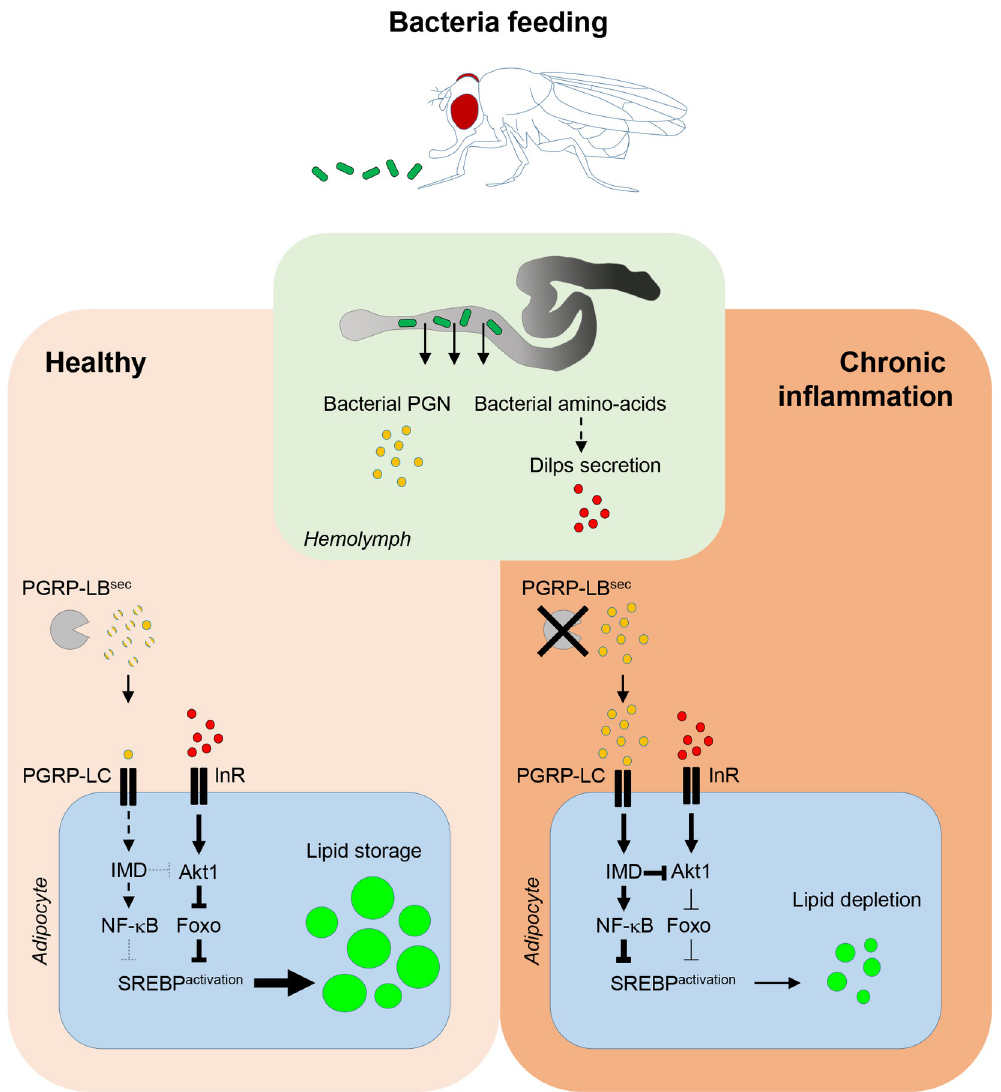
triggers Dilps secretion by neurosecretory cells of the central brain _leading to the systemic activation of the insulin/Tor signaling pathways and the activation of SREBP in adipocytes in order to sustain lipogenesis. Simultaneously, gut-born PGN diffuses into the hemolymph where it is degraded by the secreted amidase PGRP-LB sec . Upon chronic inflammation due to the lack of PGRP-LB sec and accumulation of PGN, the constitutive activation of the IMD signaling pathway promotes lipid depletion via inhibition of SREBP activation in